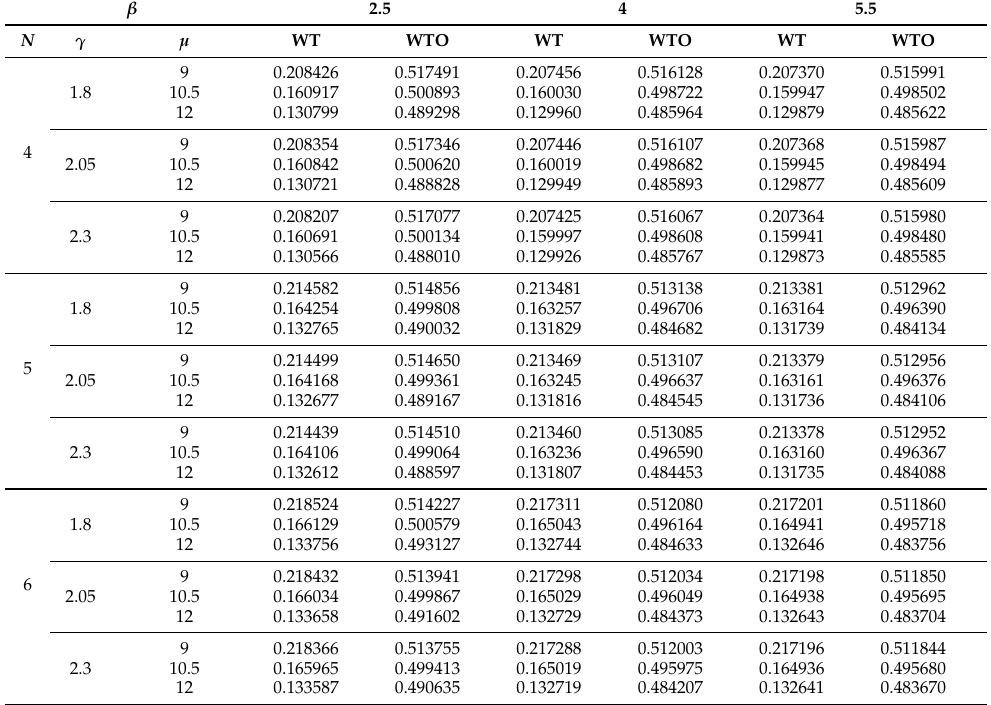
Table 3. WT, WTO under the parameter variation λ 1 , λ 2 , θ 1 , θ 2